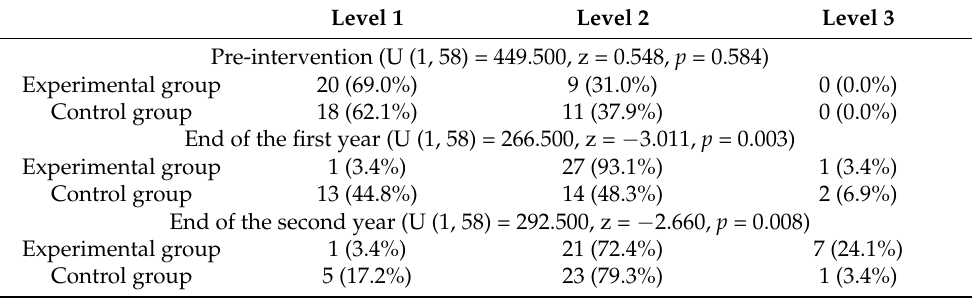
Table 2. Number and percentages of students for conceptions of career attainment by